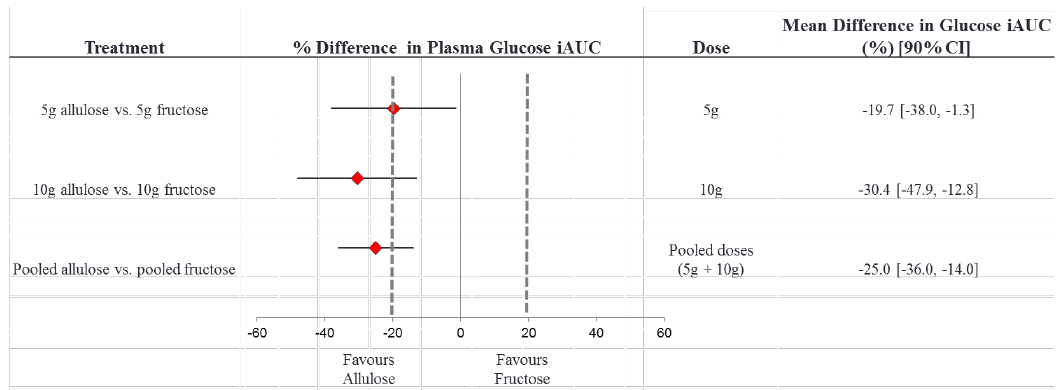
Figure 3. Equivalence test comparing the effect of allulose to fructose on plasma glucose iAUC. % difference plasma glucose iAUC = [(allulose iAUCglucose /control iAUCglucose ) – (fructose iAUCglucose /control iAUCglucose )] × 100%. The dotted lines represent the ± 20% equivalence margins. The red diamond represents the mean difference and the black line crossing through the diamond represents the 90% CI. CI, confidence interval; iAUC, incremental area under the curve.